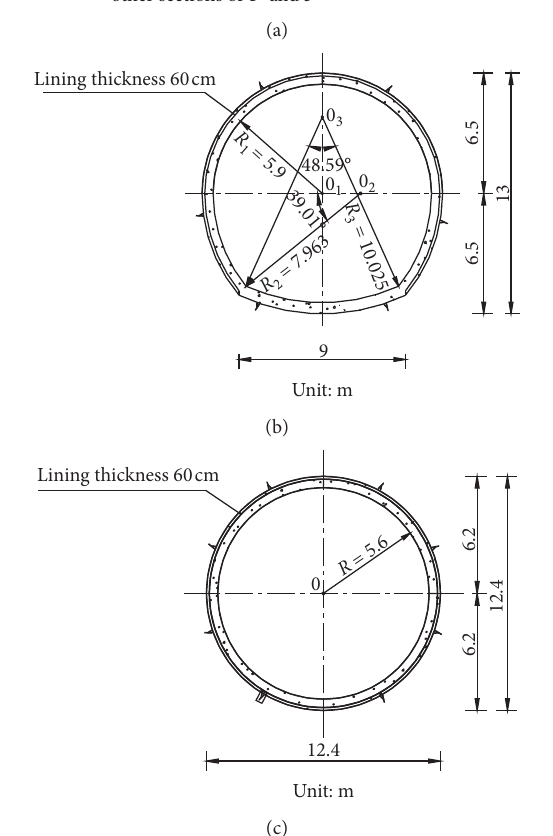
Figure 3: Construction design drawing of Jinping II diversion tunnels: (a) excavation sections of the diversion tunnel by the TBM or drilling-blasting method, (b) typical cross section of the diversion tunnel excavated by the TBM, and (c) typical cross section of the diversion tunnel excavated by drilling and